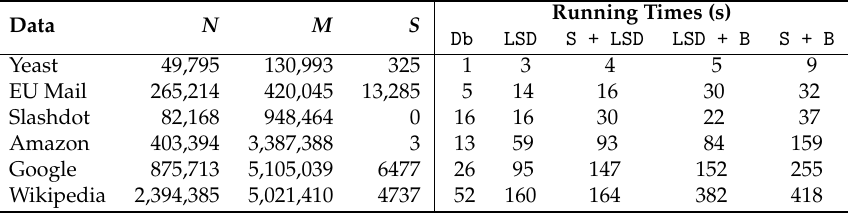
Table 1. Comparison of running times. The five combinations of algorithms compared here are: Db ( Directbubble ) refers to the new approach described in this contribution. LSD (using the auxiliary graphs ˆ G ( C ) and the stack-based superbubble detector) refers to the algorithm proposed in [7]. S + LSD combines the Sung graphs as auxiliary graphs [5] with LSD stack-based detector plus a post-filter for the false positives. LSD + B uses the LSD graph construction with the range-query-based detector of [6], and S + B uses Sung graphs together with the range-query-based detector, as well as the necessary post-filters; see [7] for full details. All computations were performed on a 2.5-GHz quad-core Intel Core i7 processor (Turbo Boost up to 3.7 GHz) with 6-MB shared L3 cache and 16 GB of 1600-MHz DDR3L onboard memory. Test datasets were taken from [11] and from the Stanford Large Network Dataset Collection [12]. For each test graph, we list the number of vertices N , the numbers of edges M , and the number S of